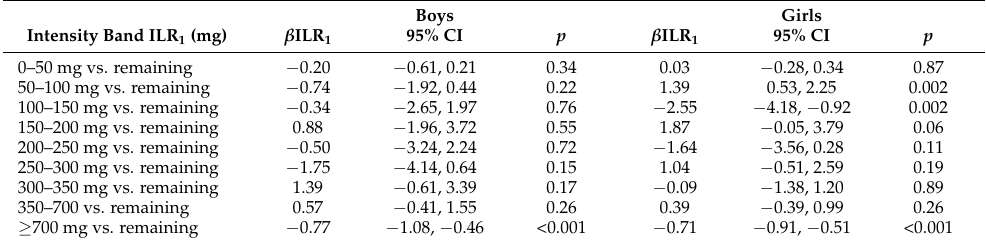
Table 3. Regression model results for boys and girls in assessing the compositional association between each intensity spectrum band ILR 1 and BMI z-score, relative to the remaining intensity bands, with adjustment for SES, centred age, accelerometer model, and accelerometer sampling frequency. Boys β ILR 1 95% CI p 0–50 mg vs.